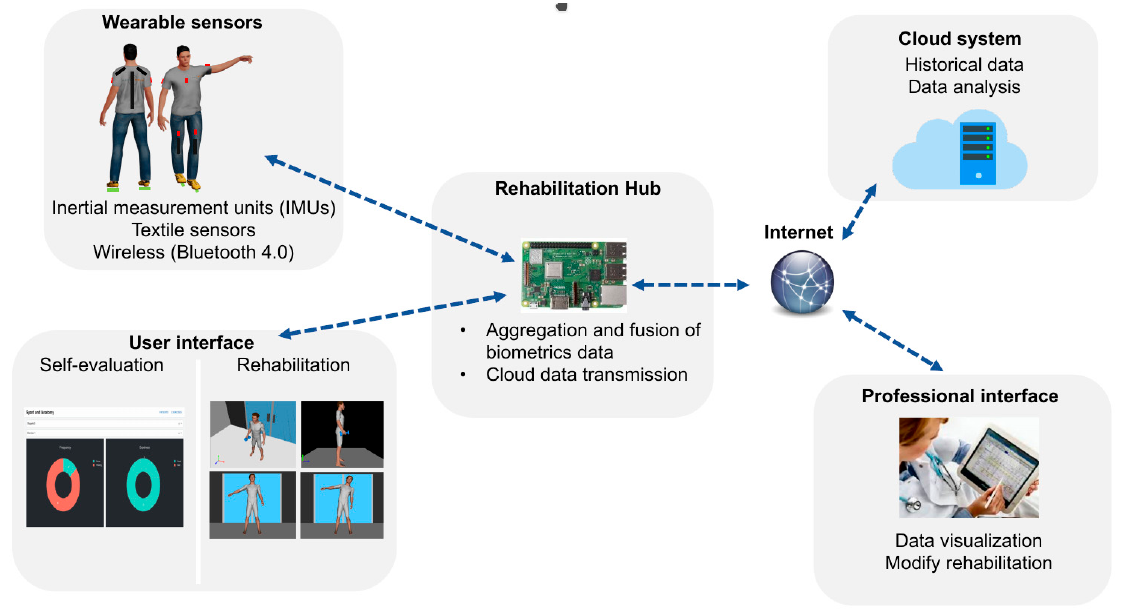
Figure 2. High-level view of the ePhysio architecture.